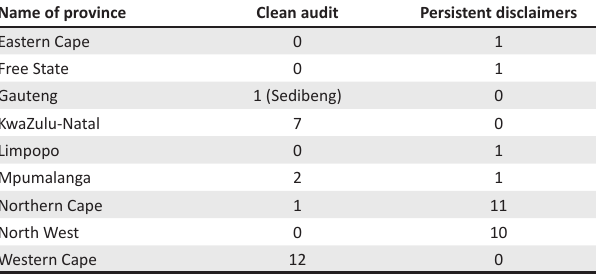
TABLE 1: Clean audits and persistent disclaimers per province (2012–2013 financial year).